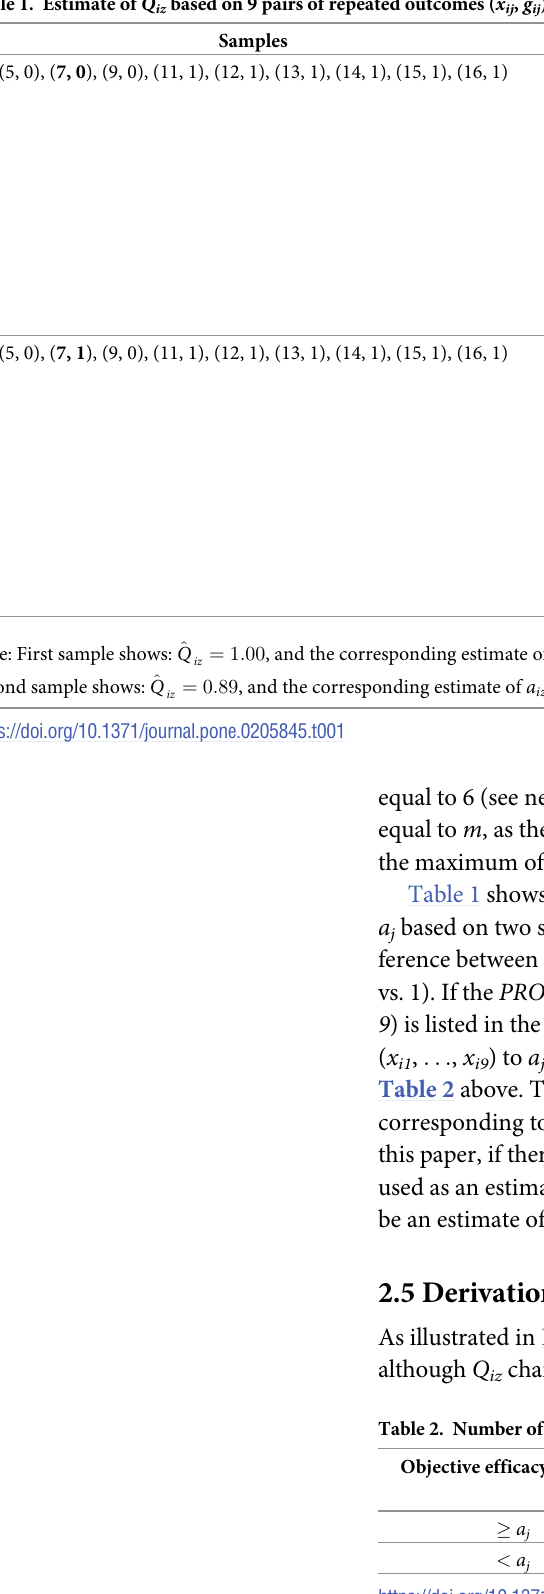
Table 2. Number of cell count at a